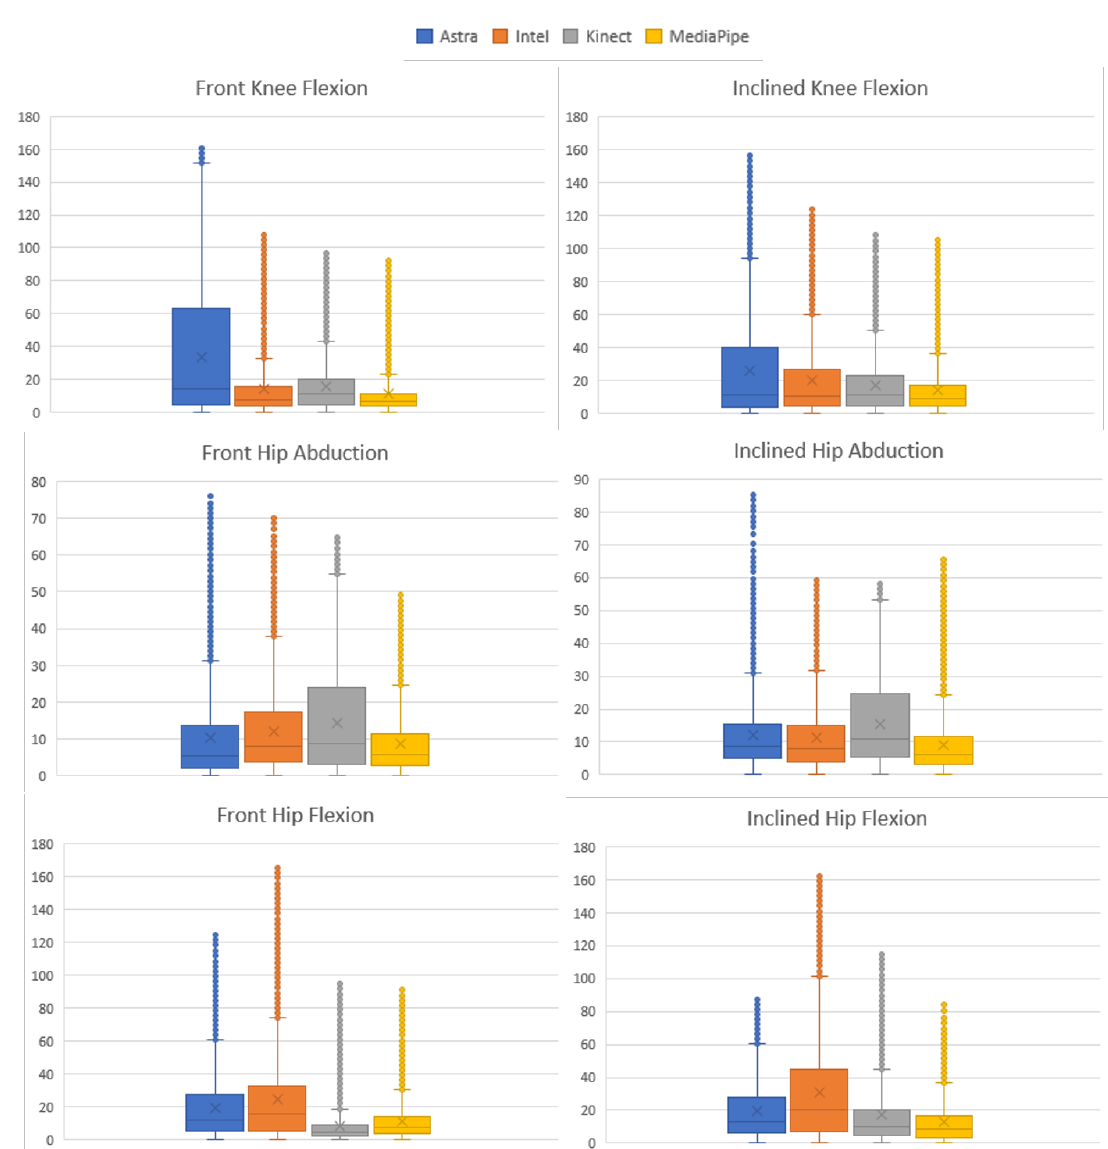
Figure 12. Grouped box plots of the absolute error (in degrees) of each LE movement. Evaluating the RMS of the E A of the movements together with the box plots, it is possible to understand the behavior of the data in comparison with the gold standard and to have indications of which presented a better performance in relation to the error. Therefore, Figure 13 contains a side-by-side comparison of all the movements in a bar chart. There is a match between the RMS and the box plot. Five of the six smallest RMS values coincided with being the same sensor with the smallest medians. Although they are complementary information, they are not correlated. A discrepancy occurred only in the Q-ABD-FR movement since the lowest median value was from Astra and the RMS from MediaPipe. This occurred due to the dispersion of the data of the first and third quartile and higher maximum, compared to the box plot of